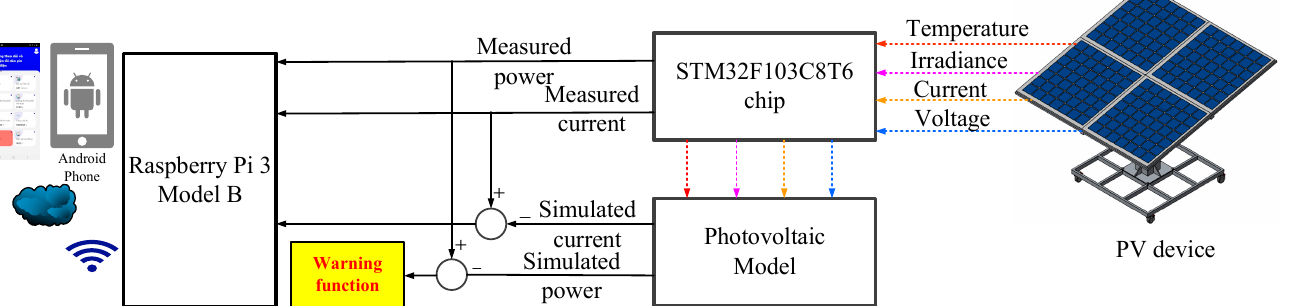
Figure 1. Configuration of proposed IoT-based PVEFD system.